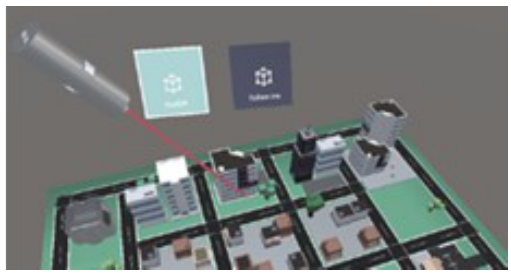
Figure 4. Visualization of the virtual laser pointer.